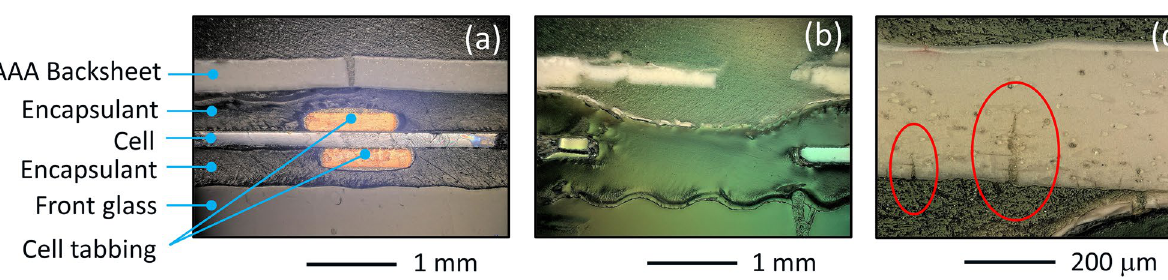
Figure 3. Cross-sectional micrographs of ( a ) the C-AST-2 sample featuring a macrocrack over a cell tab, ( b ) the Rome sample featuring a macrocrack at the space between two cells, and ( c ) the Rome sample